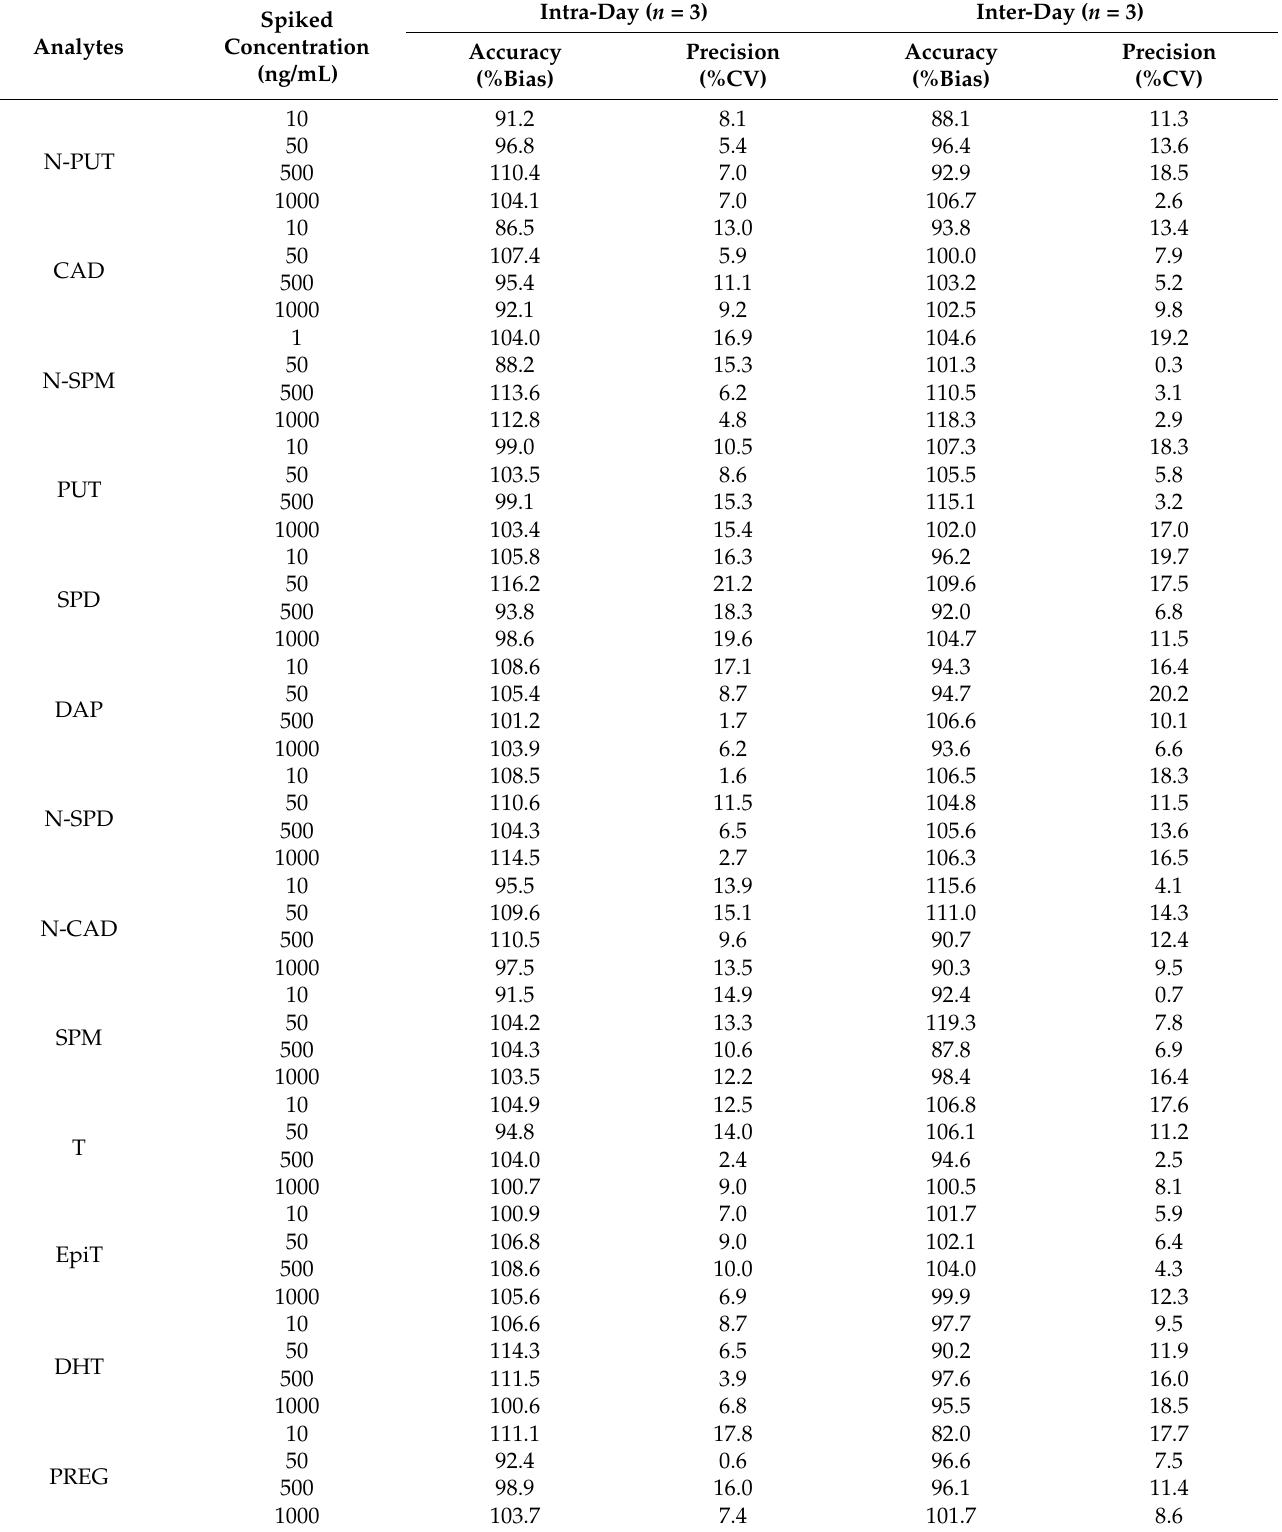
Table 2. Intra-day and inter-day validation of polyamines and